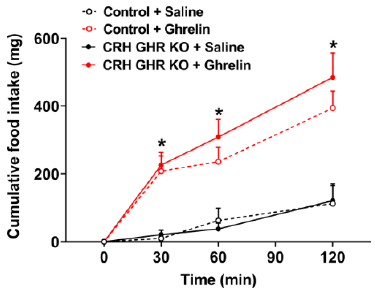
Figure 4. Ghrelin-induced food intake is normal in CRH GHR KO mice. Cumulative food intake in control ( n = 5) and CRH GHR KO ( n = 8) male mice that received saline or ghrelin injection. * Ghrelin-injected groups are significantly different compared to saline-injected groups ( p < 0.05).